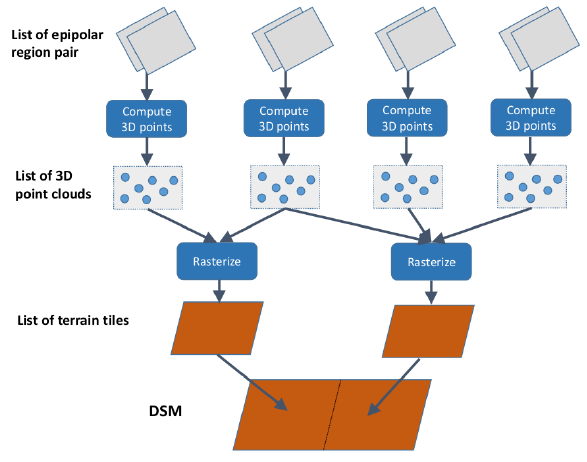
Figure 8. Dependency graph between terrain and epipolar